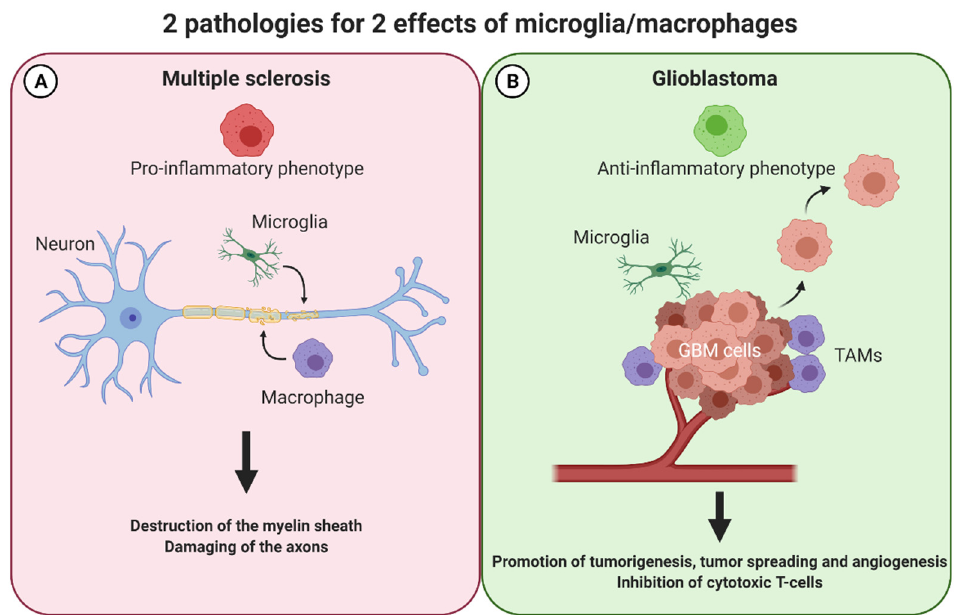
Figure 3. Macrophages have opposing effects in two pathologies of the central nervous system: mul- tiple sclerosis and glioblastoma. In multiple sclerosis ( A ), macrophages exert a M1-like phenotype and thereby attack and destroy the myelin sheath and damage the axons in the CNS. In glioblastoma ( B ), these cells adopt the opposite M2-like phenotype favoring an anti-inflammatory milieu. Conse- quently, tumorigenesis, tumor-spreading, and angiogenesis is promoted whereas cytotoxic T-cells are inhibited. CNS: central nervous system, TAMs: tumor associated macrophages.